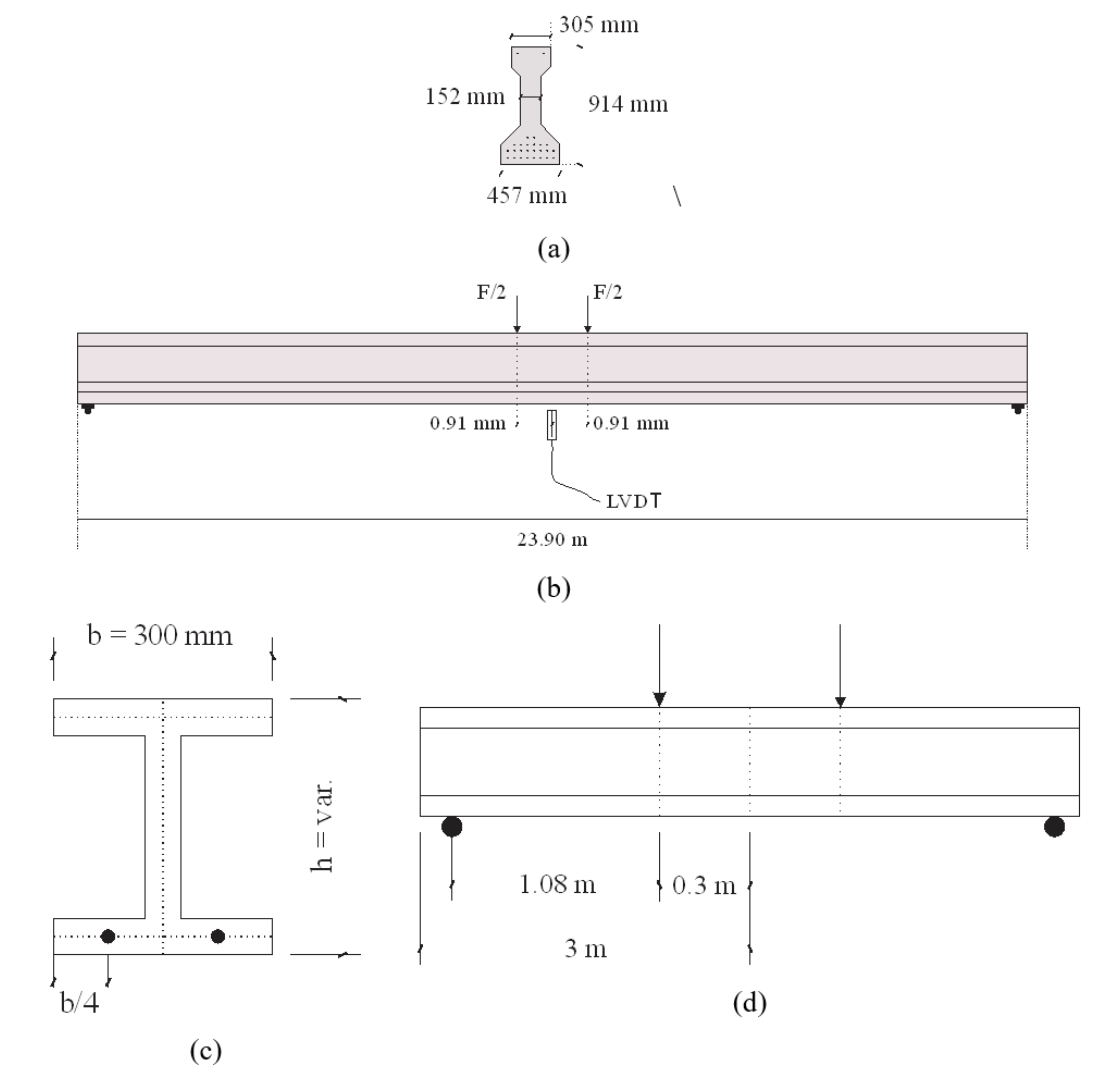
Figure 3. Studied girders: PCI AASHTO Type II: (a) cross-section, (b) Scheme test [15]. I-sections: (c) cross-section e (d) Scheme